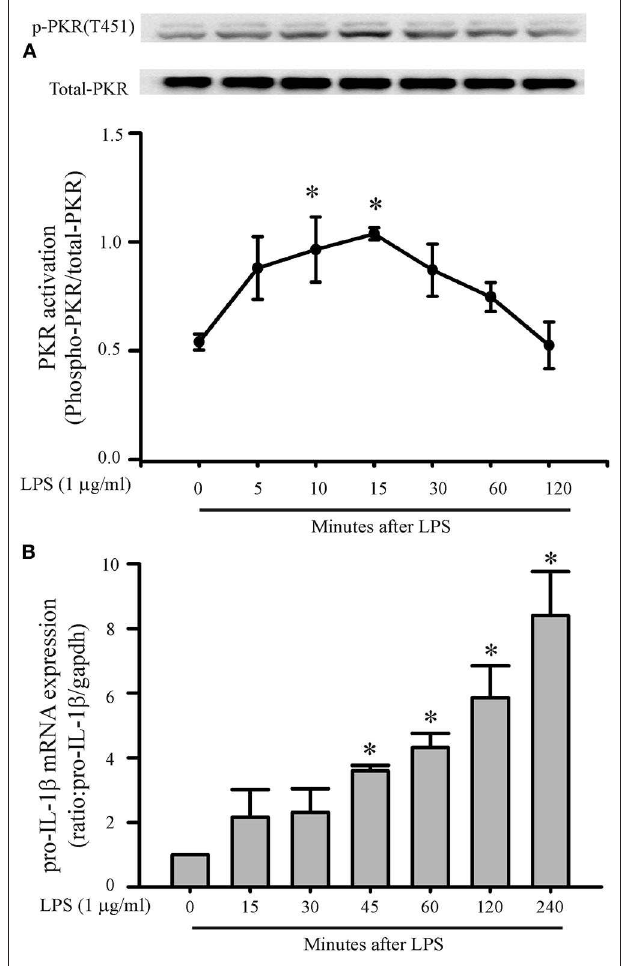
FIGURE 1 | LPS increases PKR phosphorylation and pro-IL-1 β mRNA expression. Fibroblasts were challenged with LPS (1 µ g/mL) and at indicated times thereafter harvested for assessment of PKR phosphorylation (A) or message levels of pro-IL-1 β (B) . (A) Representative Western blot of PKR phosphorylation on the activation threonine 451 (p-PKR [T451]) is shown above and densitometric analysis below. (B) Pro-IL-1 β levels were assessed by RT-PCR. The forward and reverse primers for Pro-IL-1 β were F: gatccacactctccagctgca , R: caaccaacaactgatattctccatg. n = 3 for both (A,B) , * p < 0.05 as compared to control